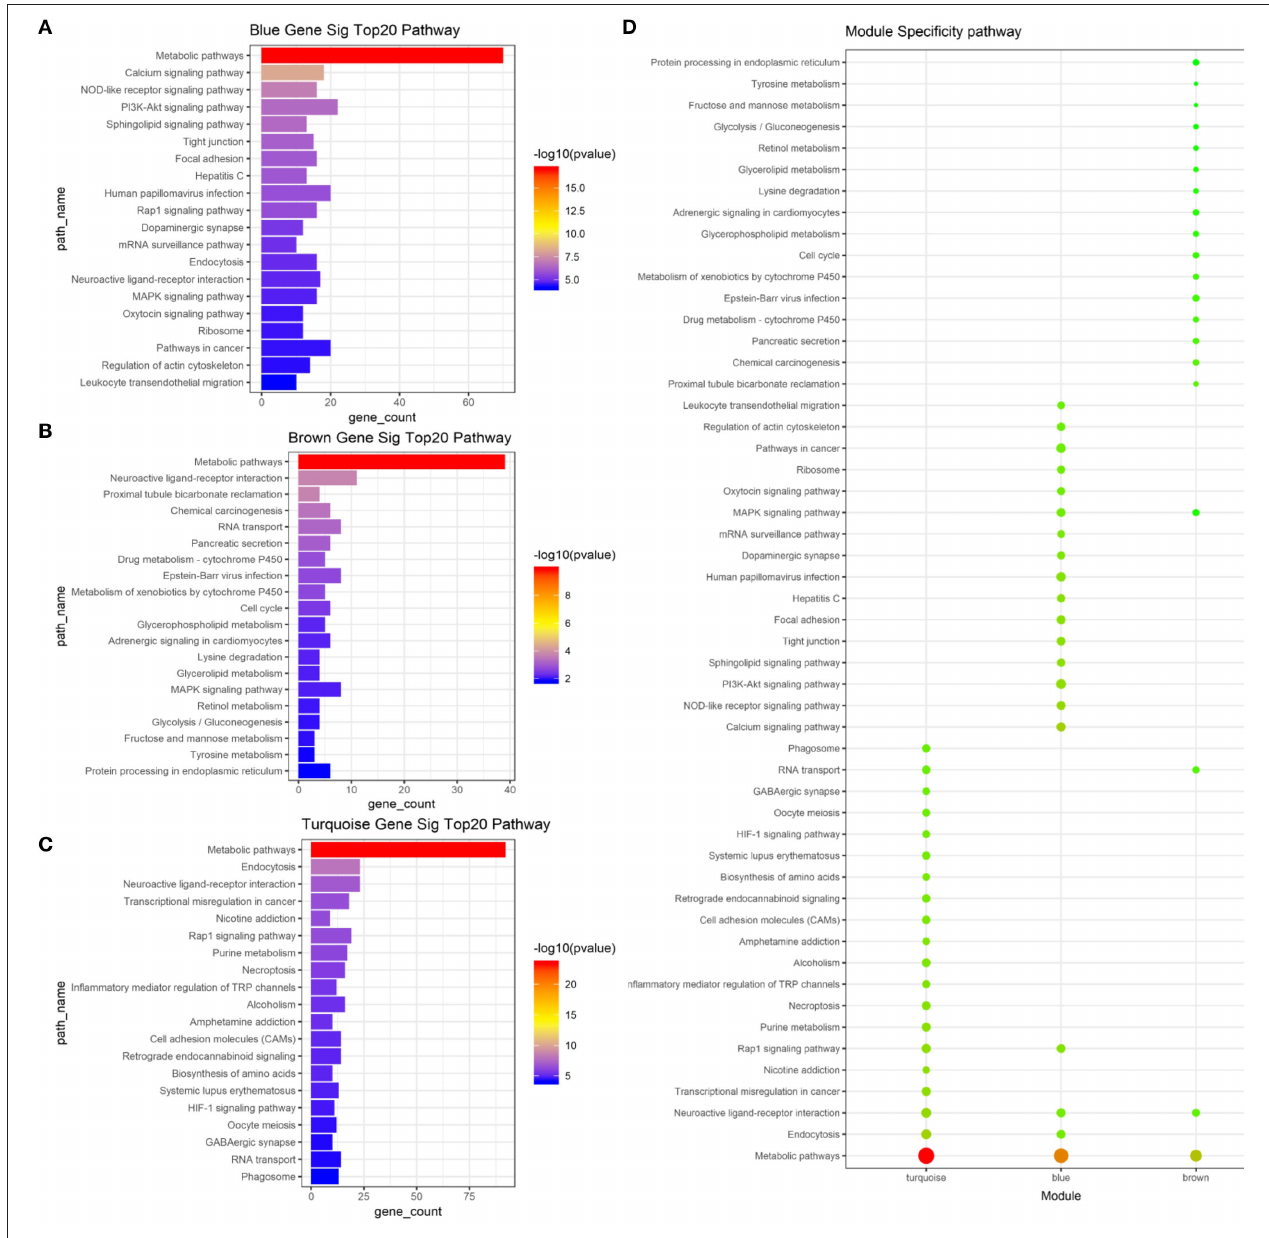
FIGURE 6 | Result of pathway analysis about mRNA based on WGCNA. (A) Top 20 enriched pathways in blue module (B) . Top 20 enriched pathways in brown module. (C) Top 20 enriched pathways in turquoise module. (D) Module specificity pathways. The vertical axis shows the results of pathway analysis, and the horizontal axis shows the different modules. The color of the round shape shows transitional values (log10 of q value), and the size shows the number of genes that were enriched. mRNA, messenger RNA; WGCNA, weighted gene co-expression network analysis.